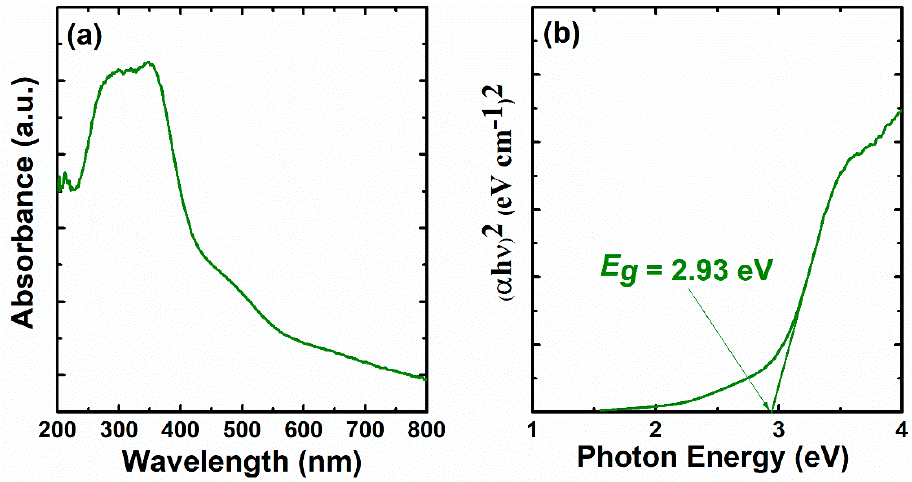
Figure 6. UV–Vis spectrum of sample ( a ), and Plot of ( α h ν ) 2 versus photon energy ( b ). The corresponding Tauc plot of ( α h ν ) 2 is presented in Figure 6b. The E g for the catalyst was observed from the straight line’s intersection with the photon energy h ν axis. E g